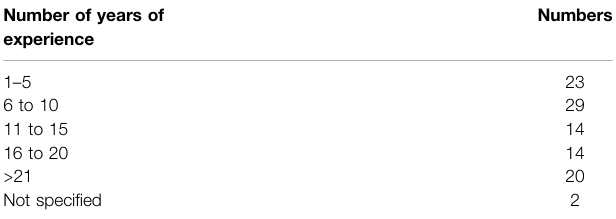
TABLE 5 | Number of years of